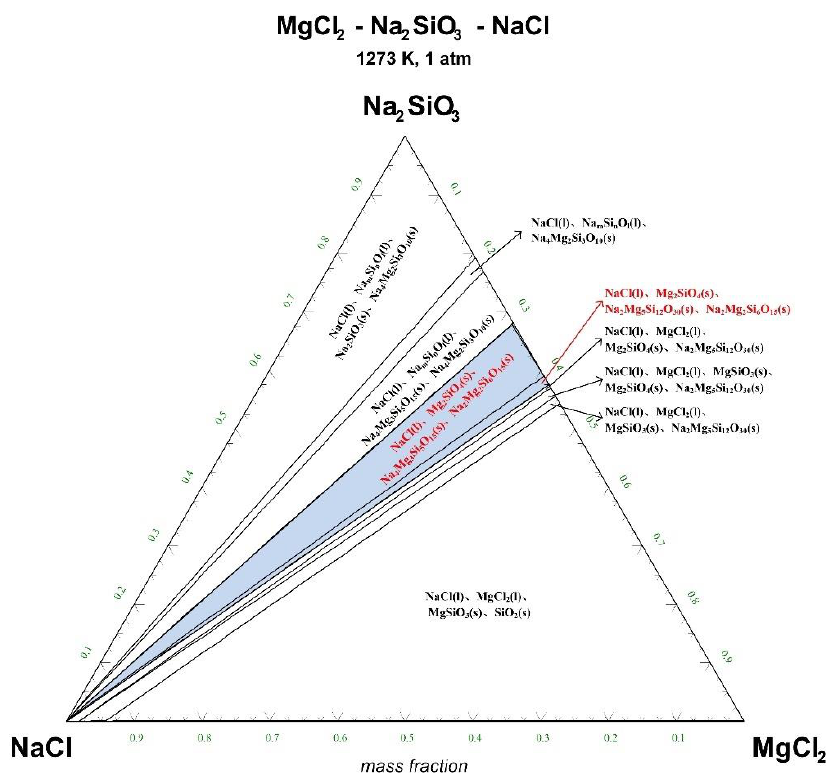
Figure 6. Ternary phase diagram of MgCl 2 -Na 2 SiO 3 -NaCl system at 1273 K. (l — liquid; s — solid).